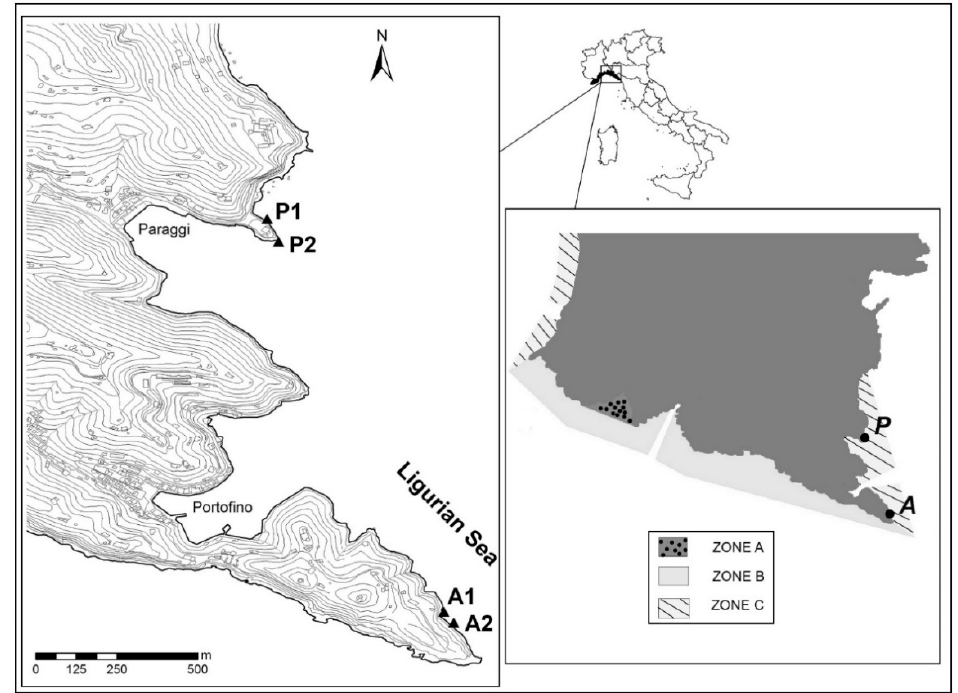
Figure 1. Map of the study area (Portofino, Genoa, Italy) with indication of the sampling stations: P: Paraggi; A: Aurora; 1: sub-vertical slope; 2: inclined slope. Zonation of the Marine Protected Area: Zone A, integral reserve zone; Zone B, general reserve zone; Zone C, partial reserve zone.